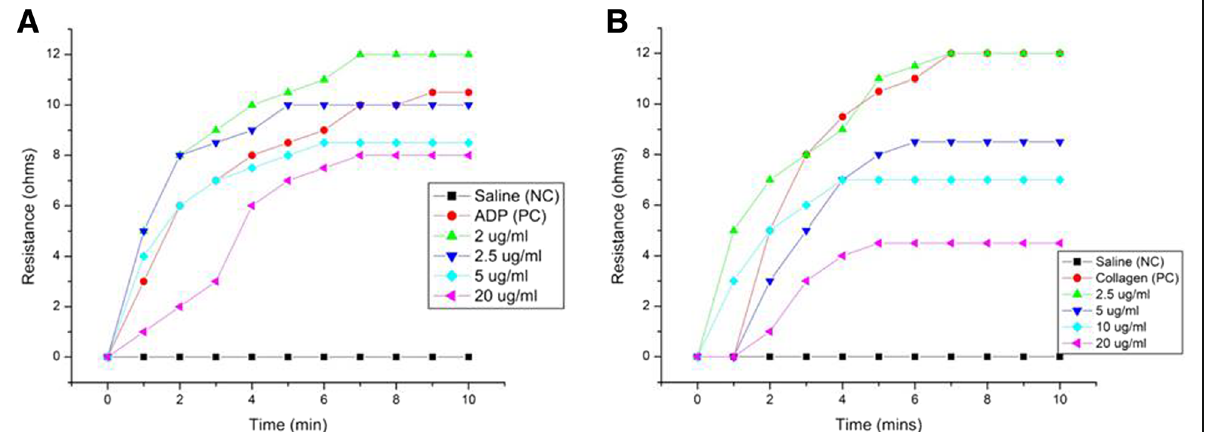
Fig. 8 Effect of AiP1 on ADP and collagen-induced platelet aggregation. A An increase in platelet aggregation was observed in platelets treated with 2 μ g of AiP1. At higher doses, a dose-dependent inhibition of platelet aggregation was observed; B A dose-dependent inhibition of collagen-induced platelet aggregation was observed upon treatment with AiP1